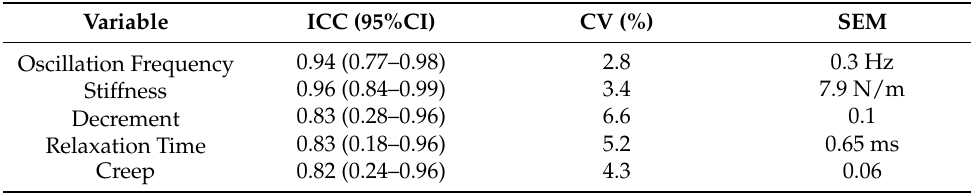
Table 1. Intersession reliability of the muscle mechanical properties data. Variable ICC (95%CI) Oscillation Frequency